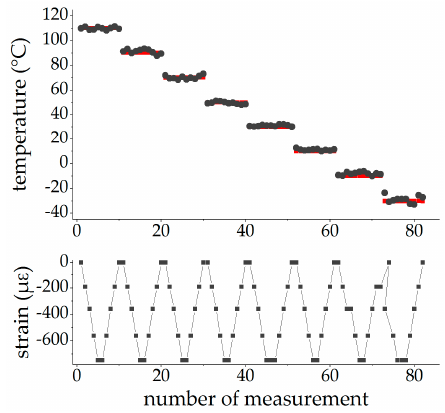
Figure 12. Strain-independent temperature measurement with surface-glued FBGs: upper graph: evaluated temperature (black dots) in comparison to the reference temperature of the Pt100 sensor (red), lower graph: applied strain.